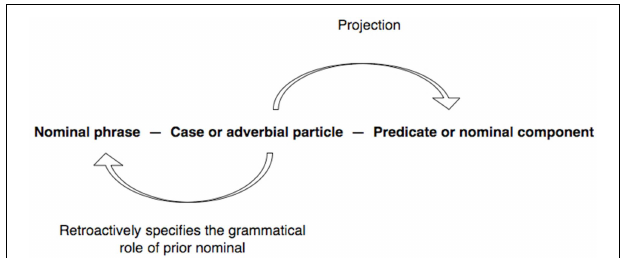
FIGURE 1 | Projective and retroactive properties of case and adverbial particles. (Adapted from Hayashi, 2004, p. 350; Tanaka, 1999, p.